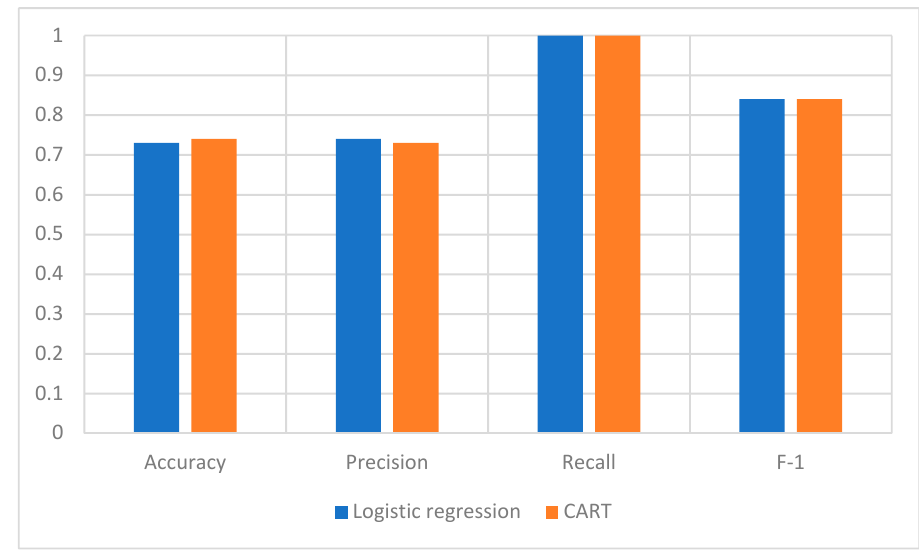
Figure 8. Comparison of prediction performance of logistic regression and CART models.